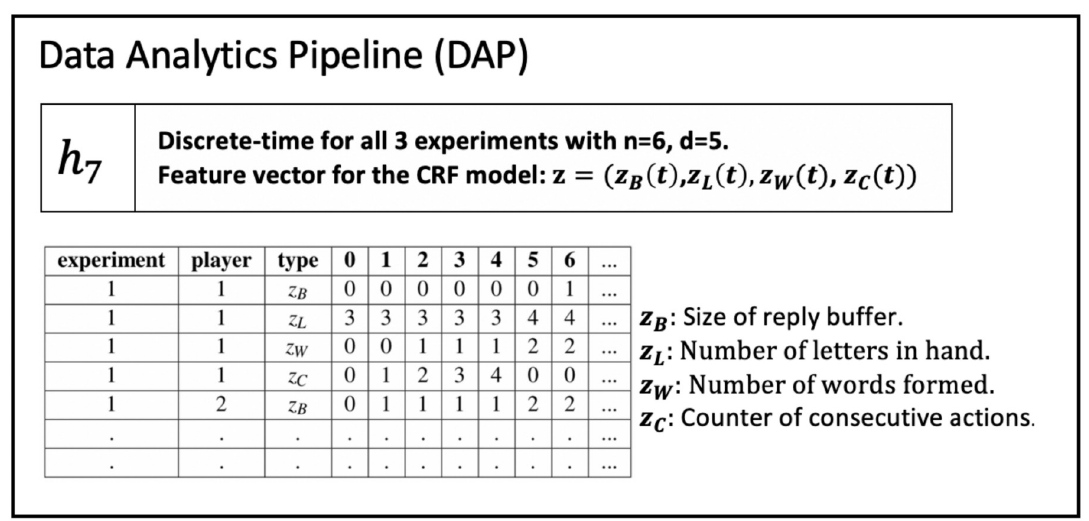
Fig 16. The Data Analytics Pipeline (DAP) was executed to analyze phase 2 of three experiments with n = 6 and d = 5. The discrete time actions for all three experiments is generates by function h 7 . This latter output will inform the Property Inference pipeline for computing parameters for simulation models. Time (in seconds) is shown in the first row as 1, 2, 3, ... , and counts of the z vector components, per player and per experiment are given.